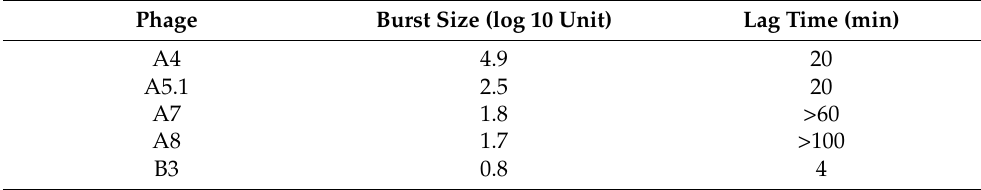
Table 2. Kinetics parameters of phage infection in Salmonella Typhimurium ATCC 14028.